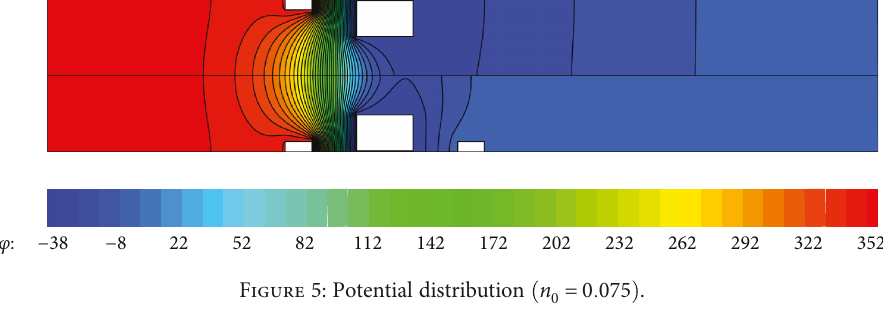
Figure 4: Beam distribution without CEX n